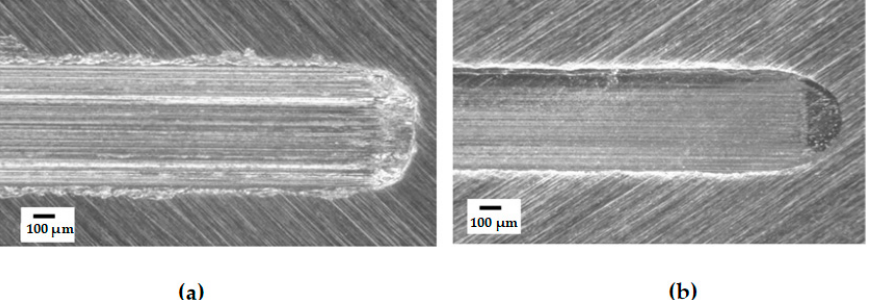
Figure 14. Optical micrographs of worn surfaces after a test (1.5 Hz, 454 m, 45 N), ( a ) Lubricated with PAO; ( b ) 5 wt.% IL in PAO (Adapted from [140]).